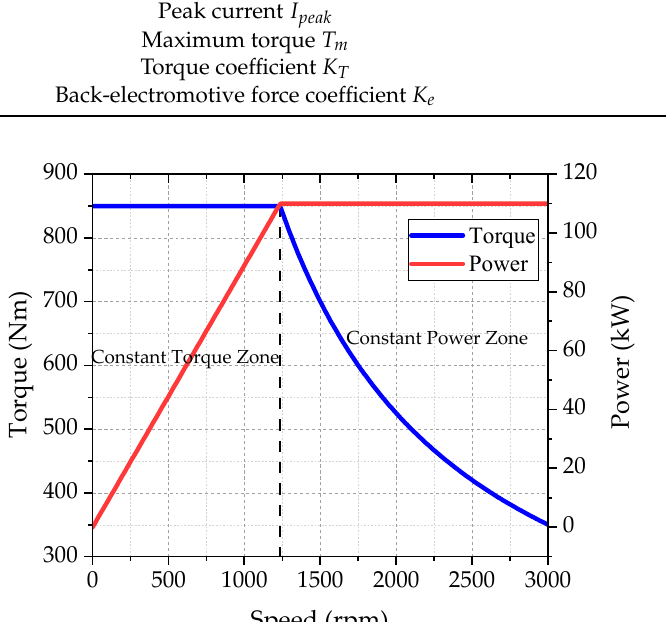
Figure 5. Torque speed diagram of the motor.